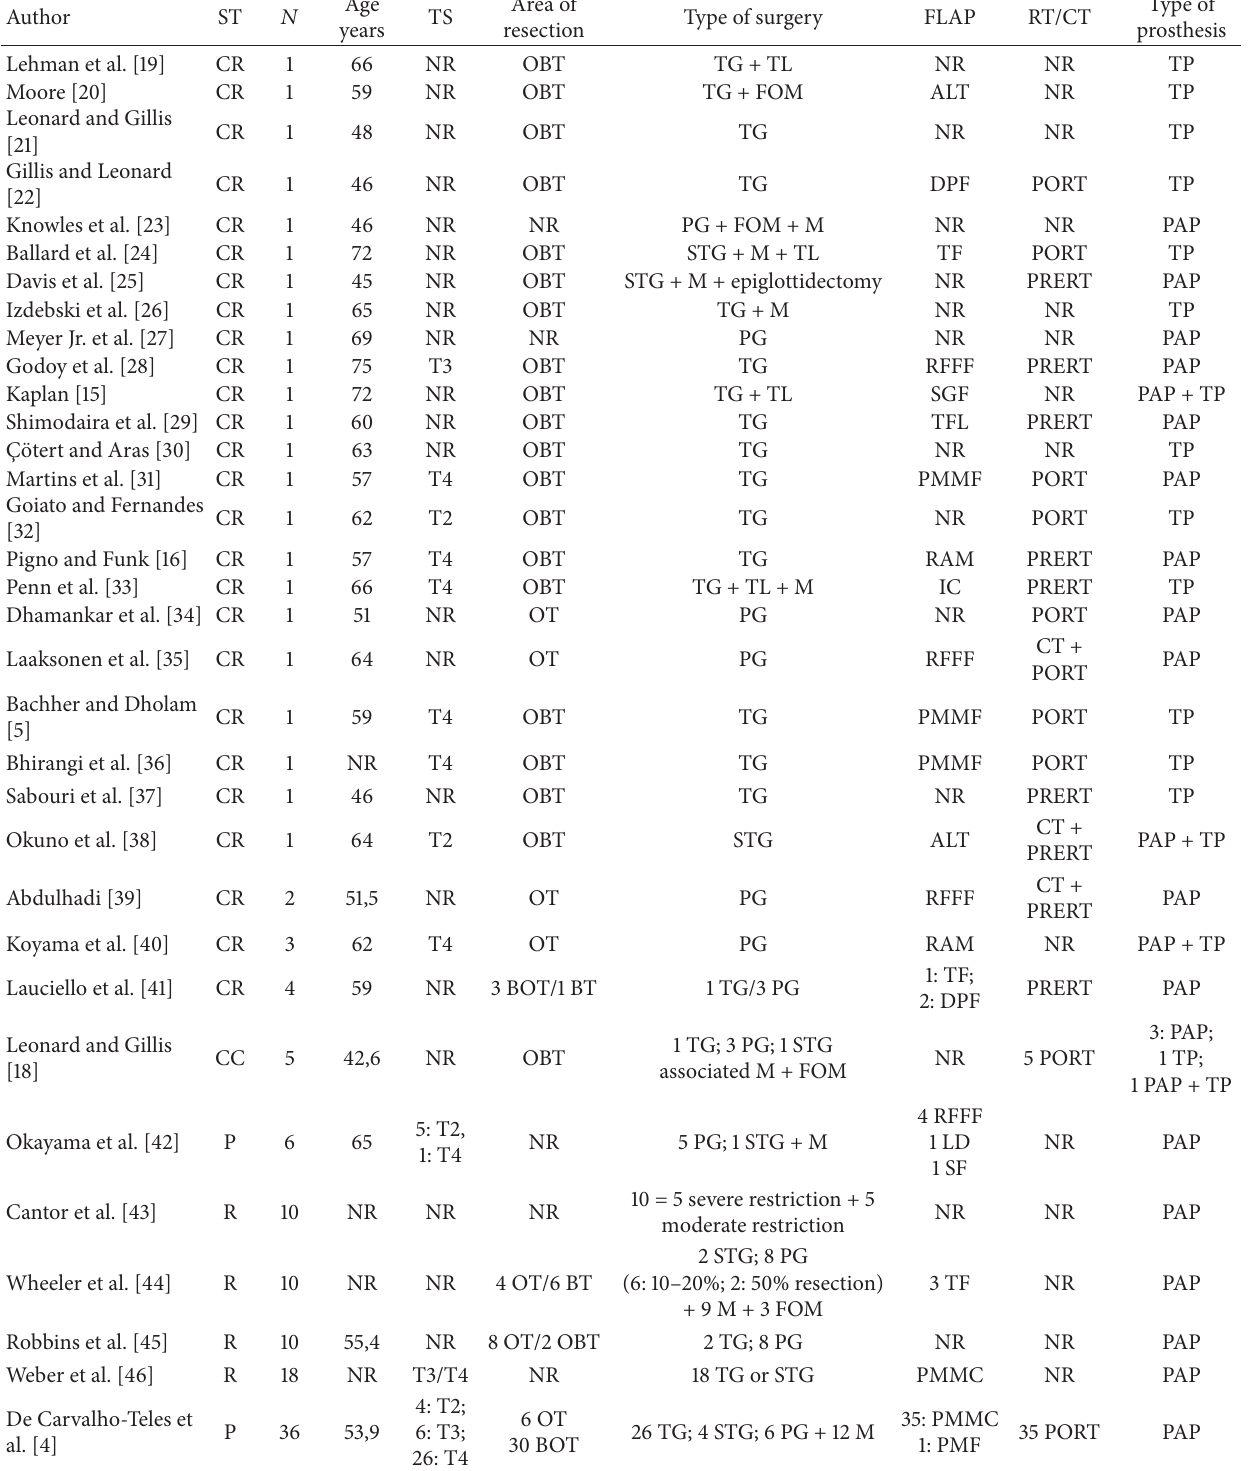
Table 1: Study type and characteristics patients of the included